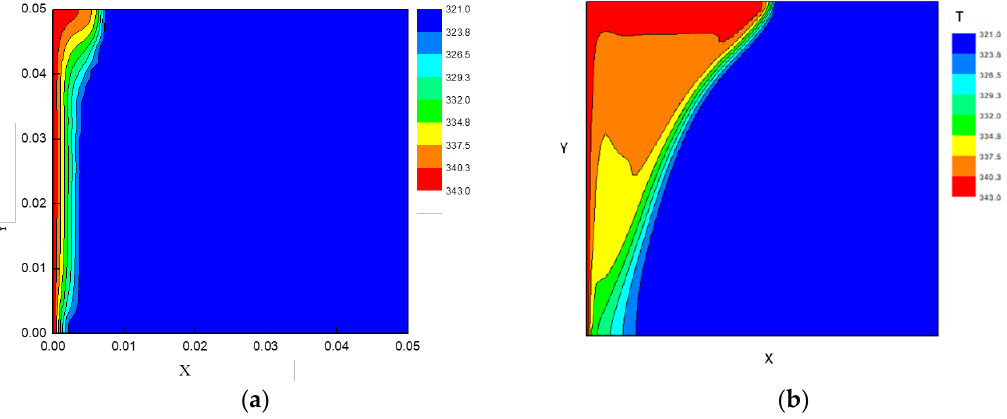
Figure 6. COMSOL results ( a ) and comparison with available data from literature ( b ) [29].